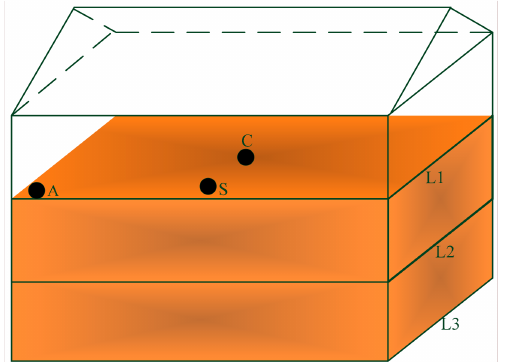
Figure 1. The illustration of position distribution for sampling points in a